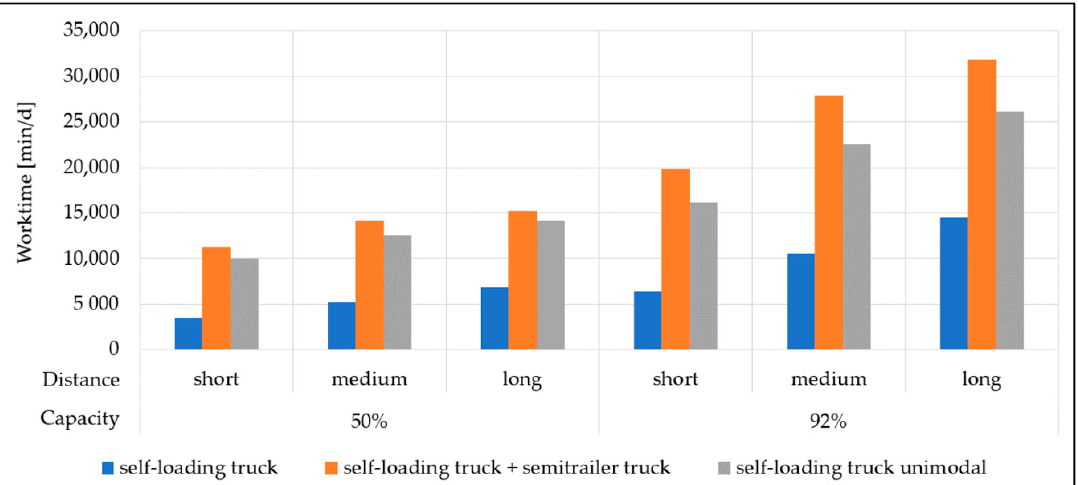
Figure 9. Total worktime for the terminal concept (self-loading truck + semitrailer truck) with explicit self-loading truck share (self-loading truck) and for the unimodal supply chain (self-loading truck unimodal) for the short, medium and long delivery time scenario and two (50% and 92% of the maximum terminal capacity) transshipment volume scenarios (min / d: minutes per day).